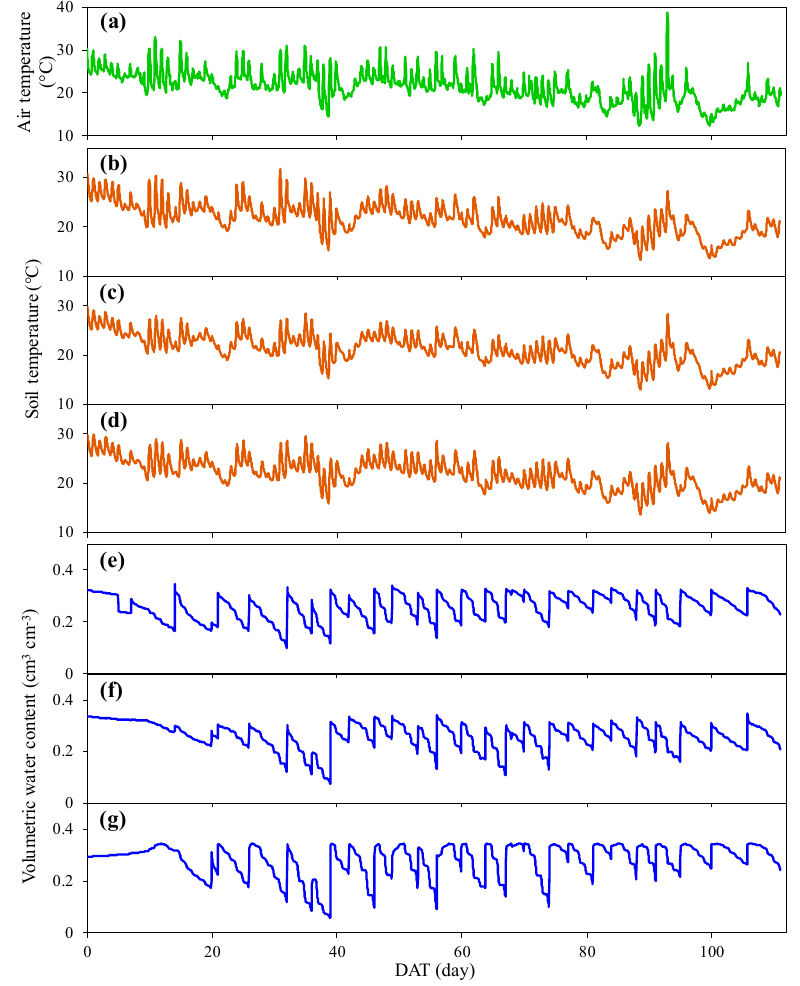
Figure 3. Temporal distributions of measured ( a ) air temperature, ( b – d ) soil temperature, and ( e – g ) volumetric water content for baskets ( b , e ) No. 12, ( c , f ) No. 13, and ( d , g ) No. 14 in the greenhouse during the cultivation period (20 September 2018 to 9 January 2019). The DAT of the X-axis represents the days after transplanting.